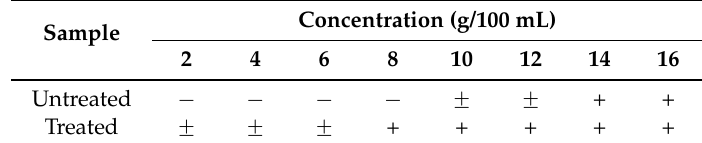
Table 6. The least gelation concentrations of untreated and alkali-treated defatted rambutan seed flours.